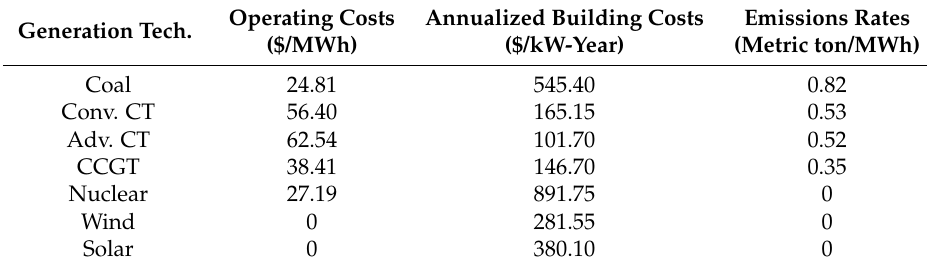
Table 4. Cost and Emission Rates of CO 2